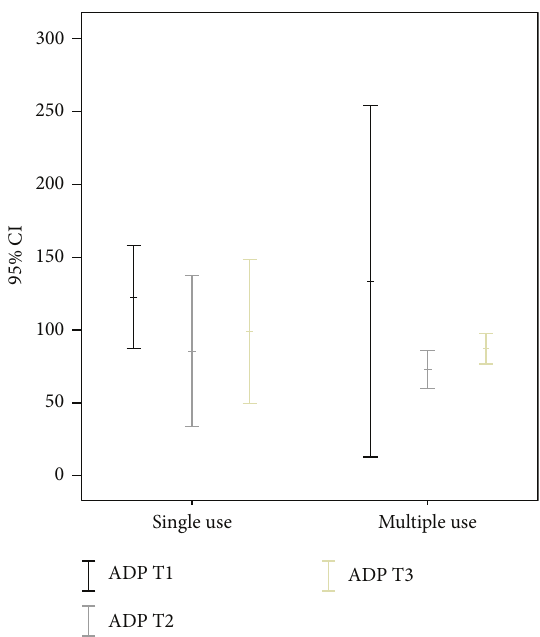
Figure 5: Results of platelet function analysis using epinephrine prior to administration (T1), half an hour after administration (T2), and three hours after administration (T3); 𝑦 -axis in seconds.